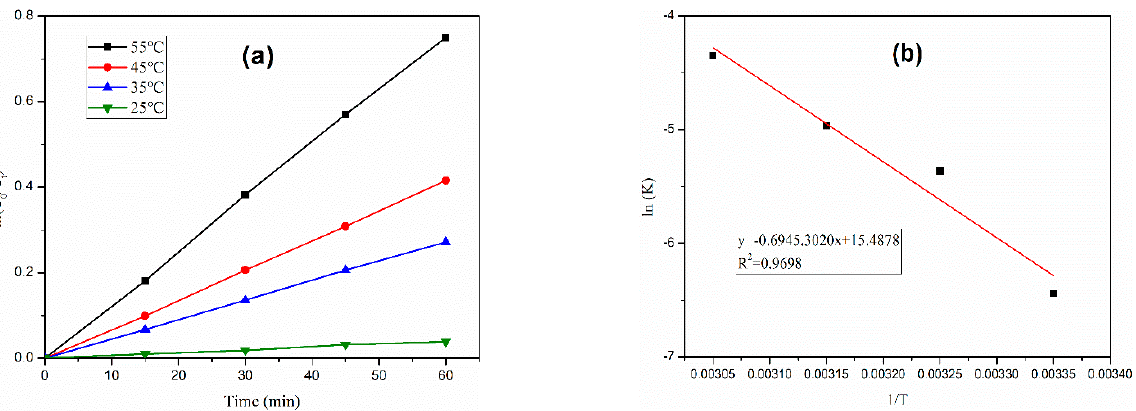
Figure 6. Effects of reaction temperature on ciprofloxacin removal.